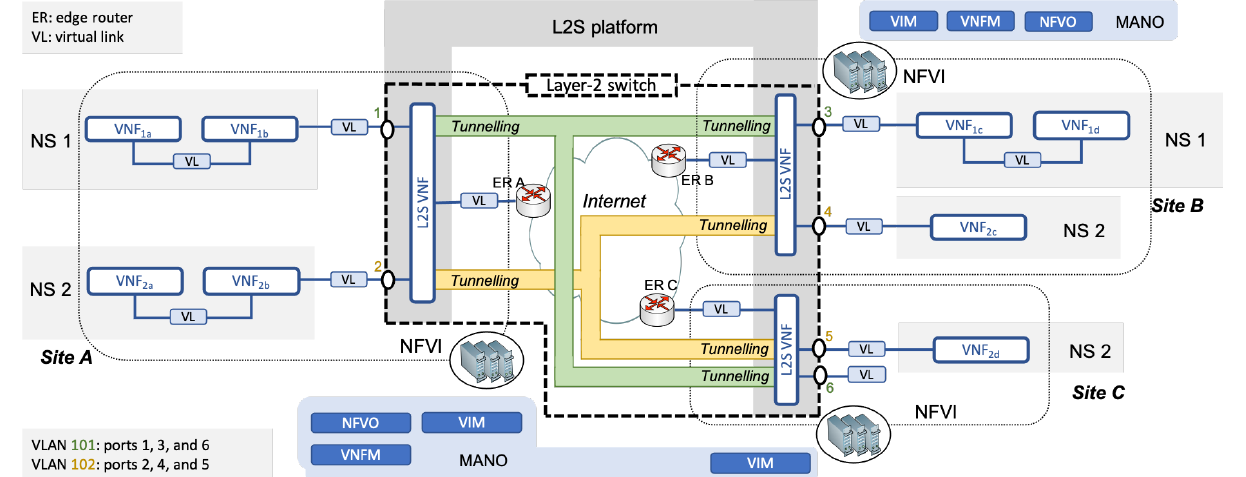
Figure 2. Conceptual design of the L 2 S